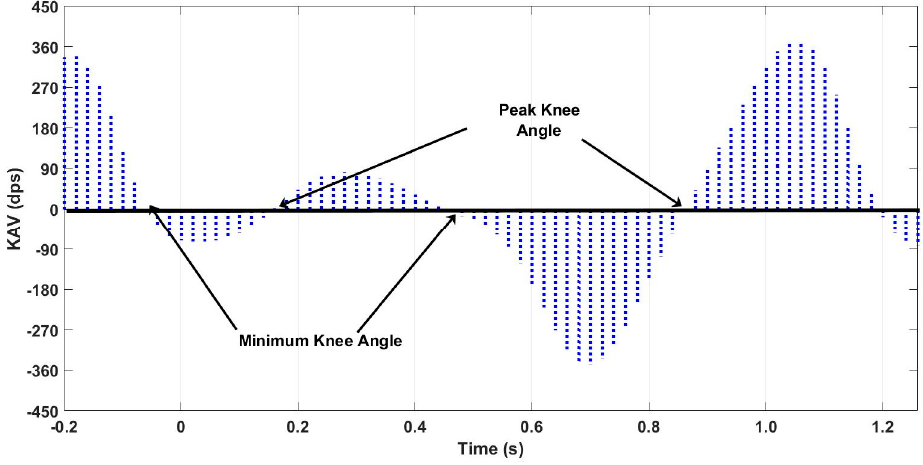
Figure 8. Peaks and troughs in the knee angular velocity signal and its relationship to knee angle.